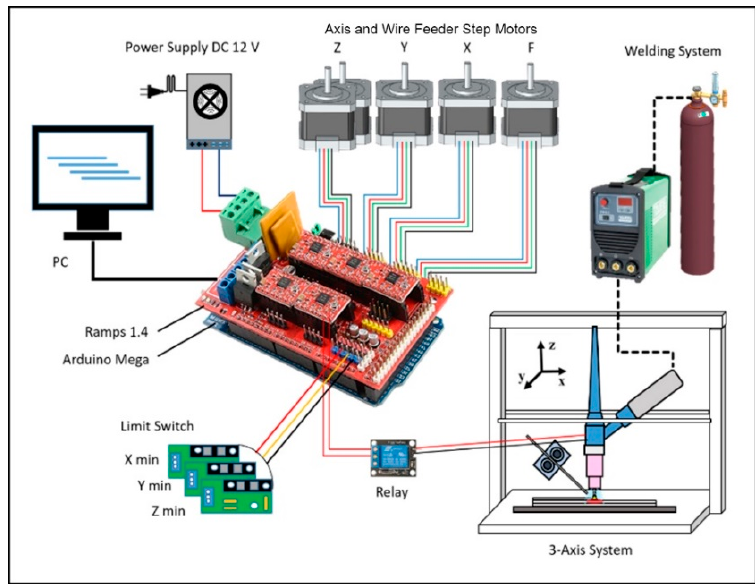
Figure 1. Schematics of the components of the WAAM system.